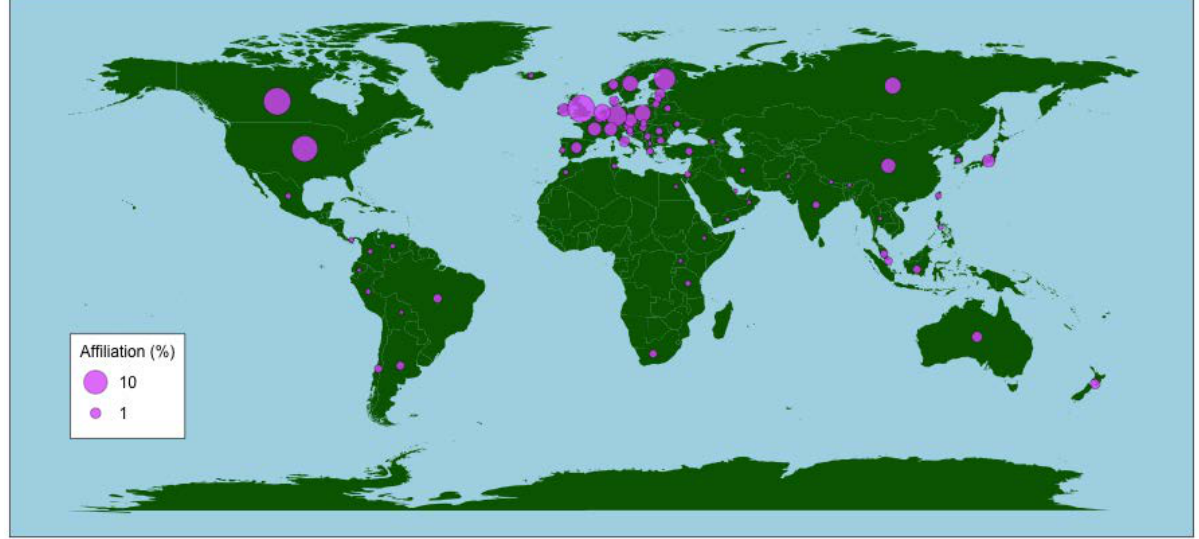
Figure 3. Proportion of affiliations per country, relative to the global total, for 1991–2017. Proportion shown by circle area. Examples 10 % and 1 % in